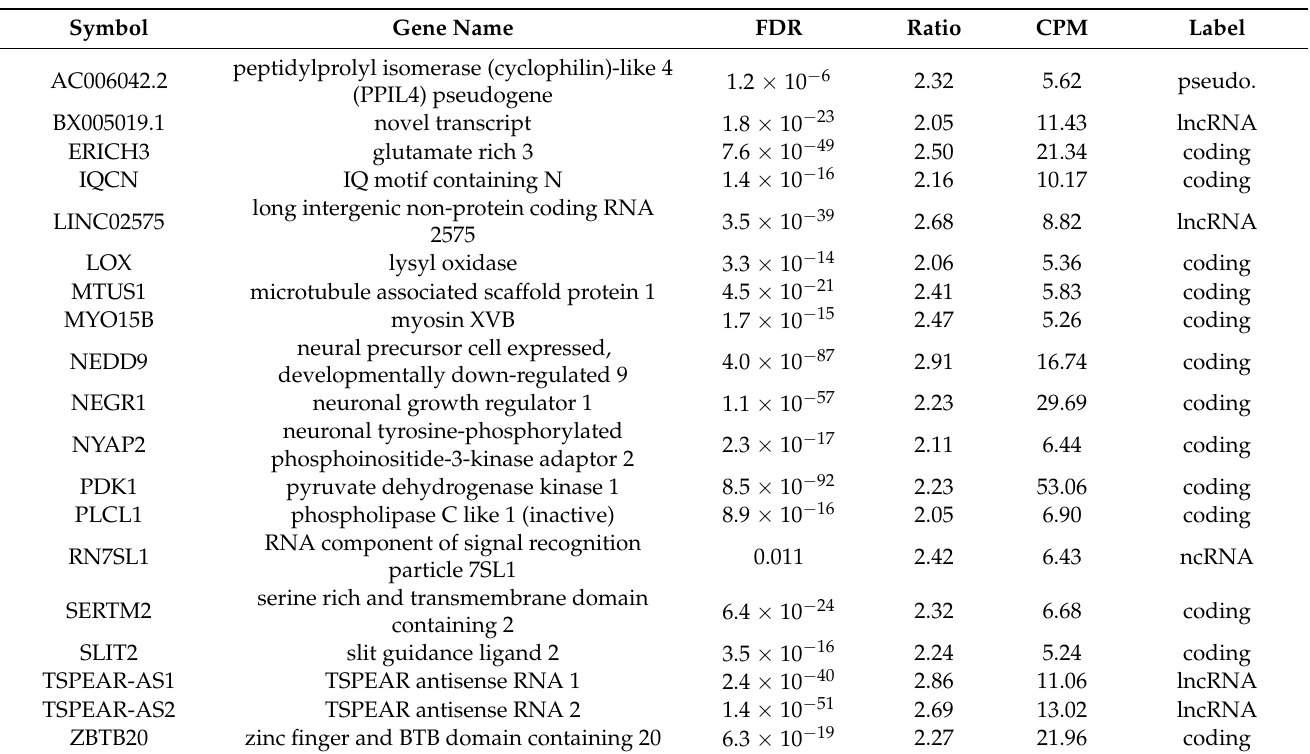
Table 2. Gene expression over-expressed (>2 folds) in SH-SY5Y exposed to Sin1 (24 h) relative to untreated cells. Symbol Gene Name Label